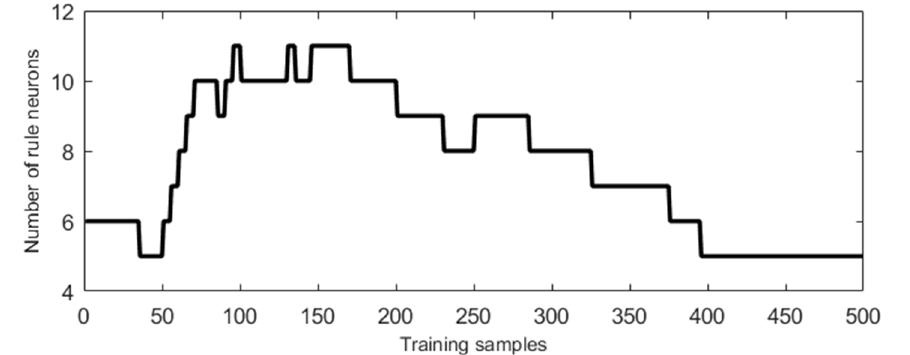
Figure 7. Neuron number change graph.